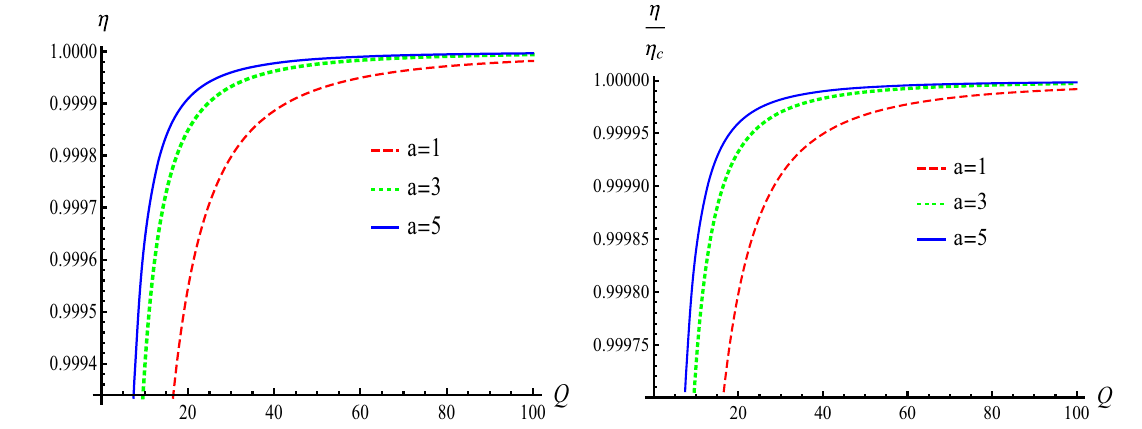
Fig. 13 The two figures above are plotted under the change of the electric charge Q at three different fixed normalization factors a , here we take α = 1